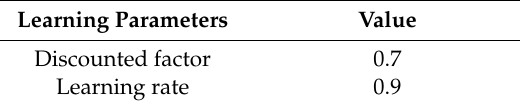
Table 7. Selection of Q learning